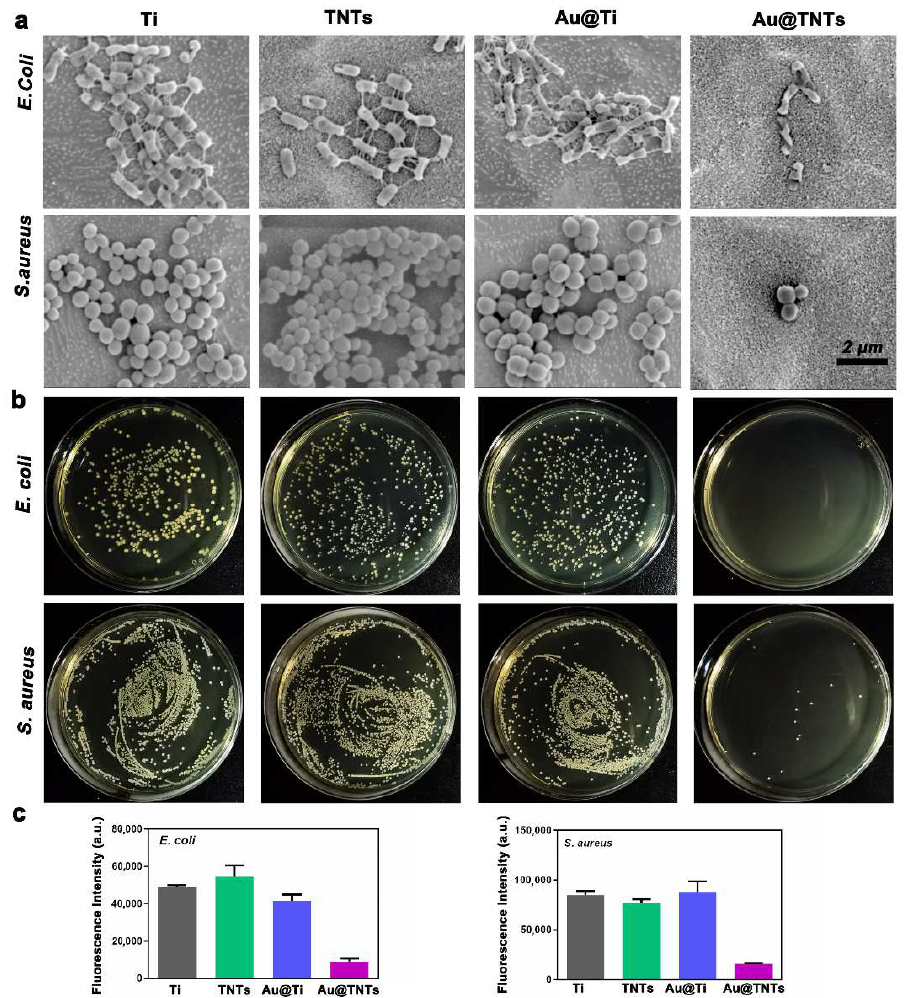
Figure 3. SEM images of E. coli and S. aureus grown on different samples ( a ). Typical photographs of E. coli and S. aureus cultured on nutrient broth medium agar for 18 h ( b ). Viability of E. coli and S. aureus evaluated by fluorescence measurements ( c ).